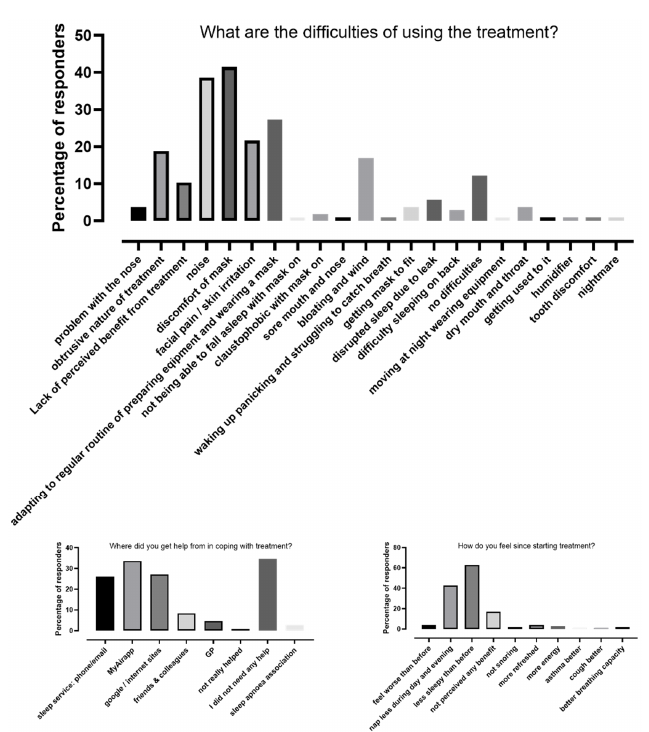
Figure 3. The result of the patient survey.